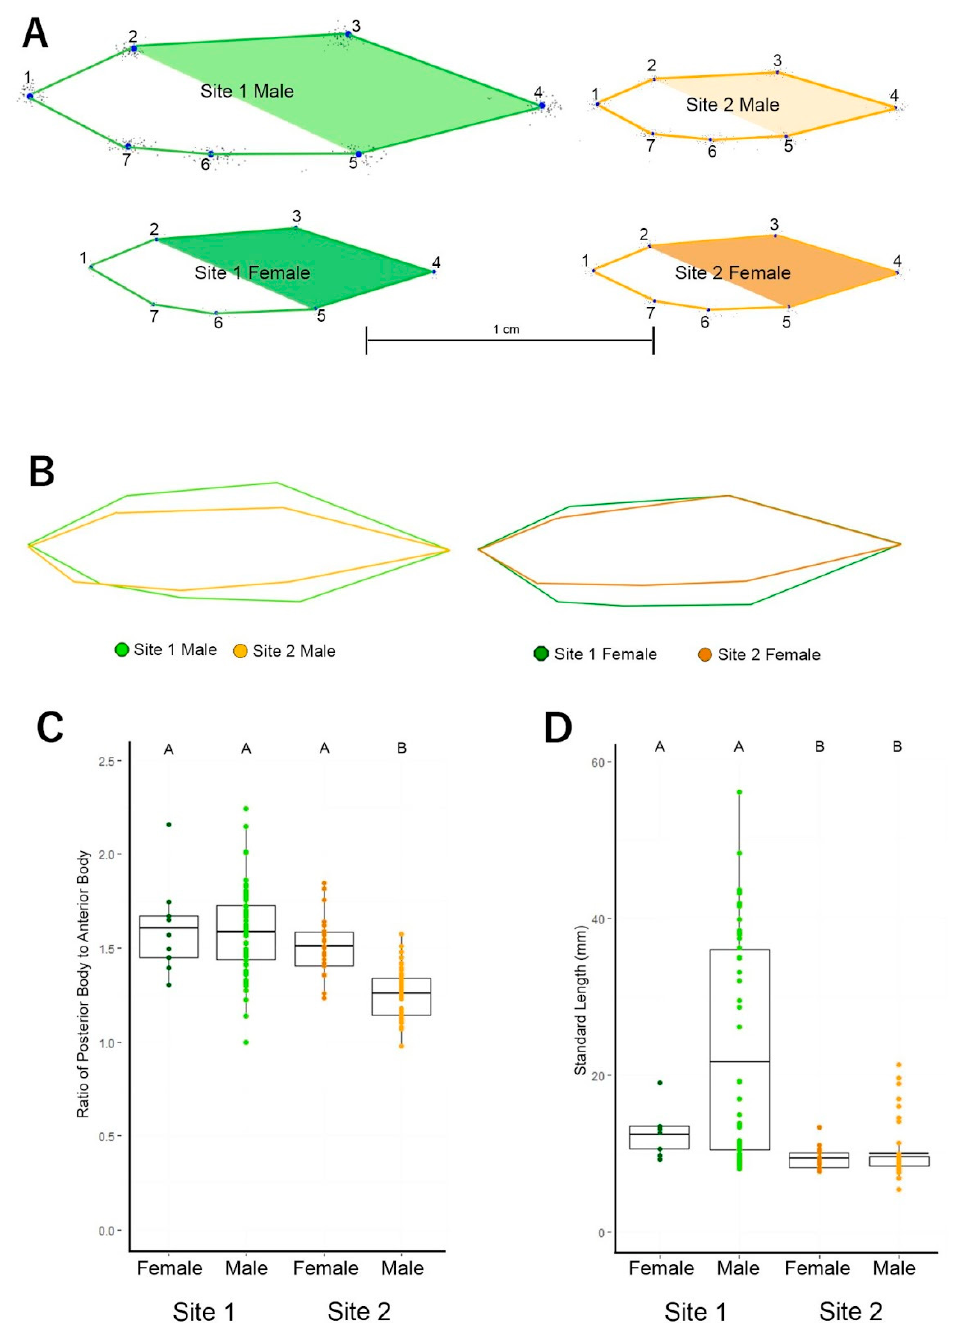
Figure 3. Consensus shape differed significantly across Population, but not Sex. The greatest variance in shape between populations was among landmarks located on the posterior dorsal skull (LM 2), anterior dorsal fin (LM 3), caudal fin (LM 4), and anterior anal fin (LM 5). ( A ) Size differences in fish between levels of Population and Sex. Shaded regions denote the posterior body region identified by PCA as contributing to shaping variance, while the white region denotes the anterior body region not identified by PCA. ( B ) Overlaid shapes of the most morphometrically-extreme fish across levels of Population and Sex. ( C ) Fish from Site 1 and Site 2 female fish had a larger posterior region of their body relative to the anterior region compared to Site 2 male fish. Individual samples are overlaid onto boxplots. Data analyzed with a two-way ANOVA. ( D ) Fish from Site 1 had a greater standard length than fish from Site 2. Statistical analysis showed that Site 2 fish, not Site 1 fish, were sexually dimorphic. Individual samples are overlaid onto boxplots. Data analyzed with a Kruskal-Wallis test. Boxplots denote means and interquartile range. Error bars indicate the range of scores. Letter markings donate significant (different letters) and non-significant (same letters) differences ( p < 0.05).